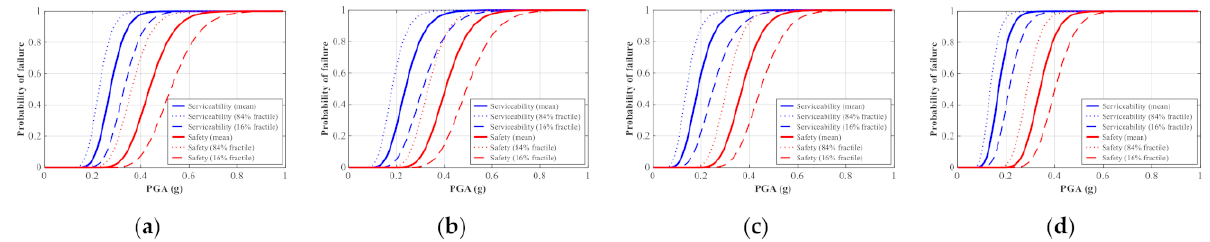
Figure 16. Fragility for mean, 16% and 84% fractile curve; ( a ) 0 years, ( b ) 25 years, ( c ) 50 years, ( d ) 75